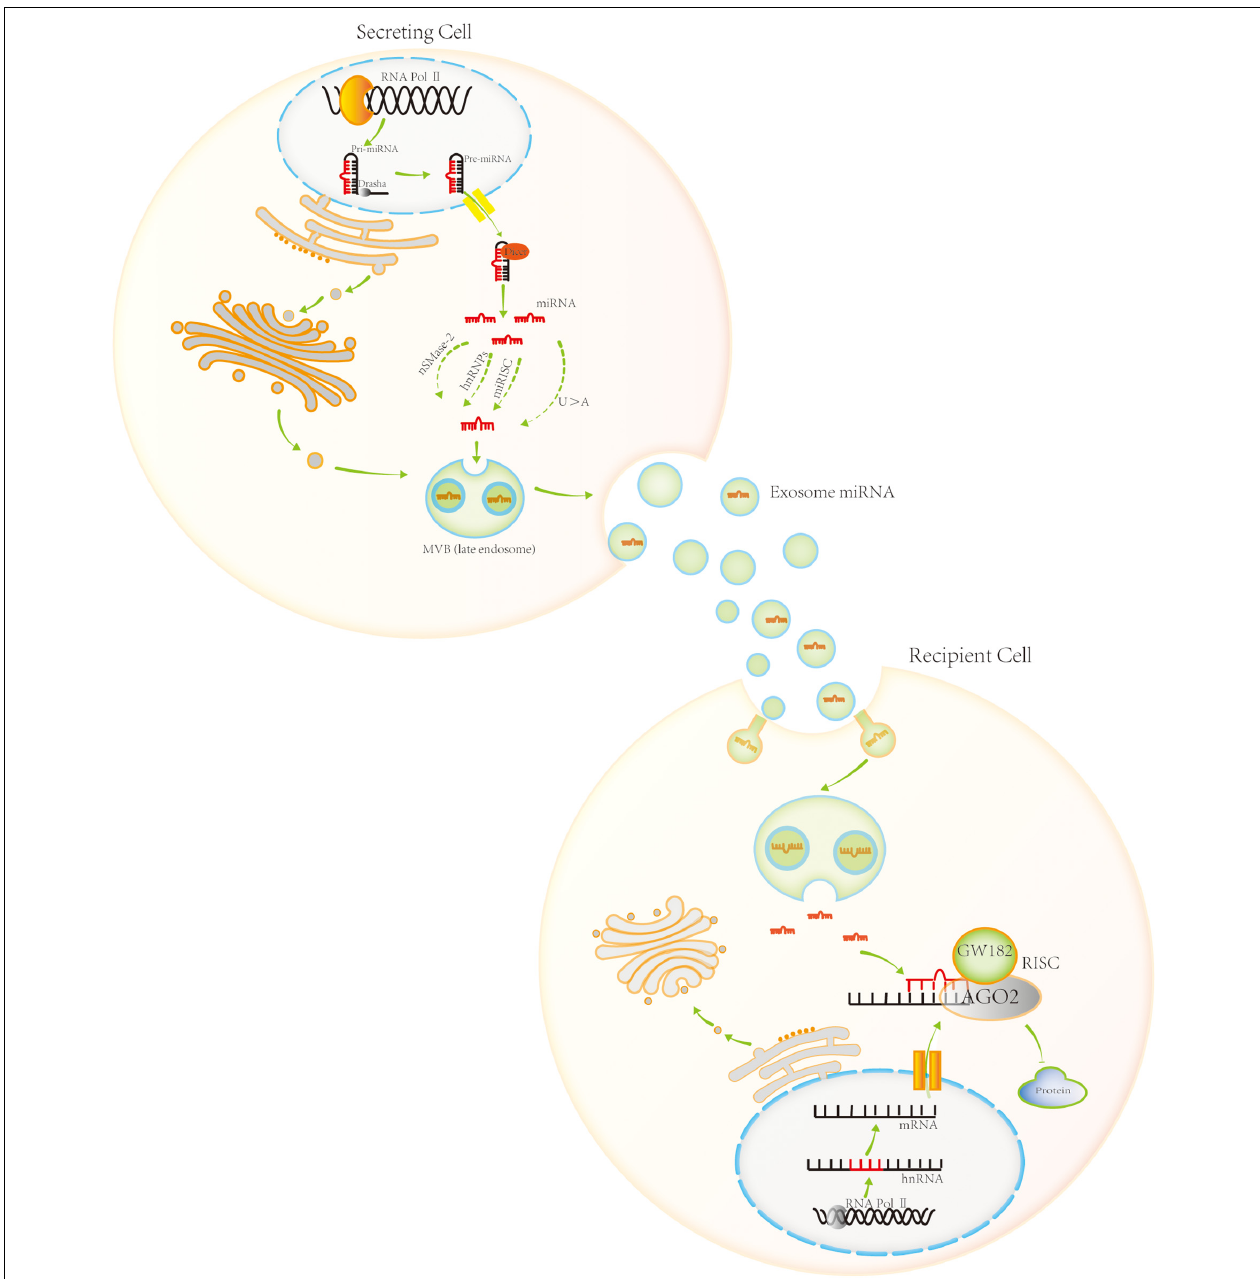
FIGURE 2 | Exosomal miRNA biogenesis, sorting, trafficking, and biological function. Most miRNAs are encoded by their own genes. RNA polymerase II transcribes these genes, producing pri-miRNA. Pri-miRNA is processed in the nucleus by Drasha, generating pre-miRNA. Pre-miRNA is then transported to the cytoplasm by Exportin 5. It is further processed in the cytoplasm by Dicer, generating mature miRNA. Four sorting pathways exist for miRNA entry into the exosome, namely, the sphingomyelinase 2-dependent pathway, hnRNP-dependent pathway, miRNA-induced silencing complex (miRISC) associated pathway, and sequence-dependent pathway involving the 3 (cid:48) -end of miRNA. Exosomal miRNA plays a role in post-transcriptional gene regulation upon uptake by neighboring or distant cell. It enters the target cell and combines with the target mRNA molecule based on partial sequence complementarity. miRNAs inhibit protein synthesis by forming miRISC, a complex with specific proteins. AGO2 and GW182 are the core components of